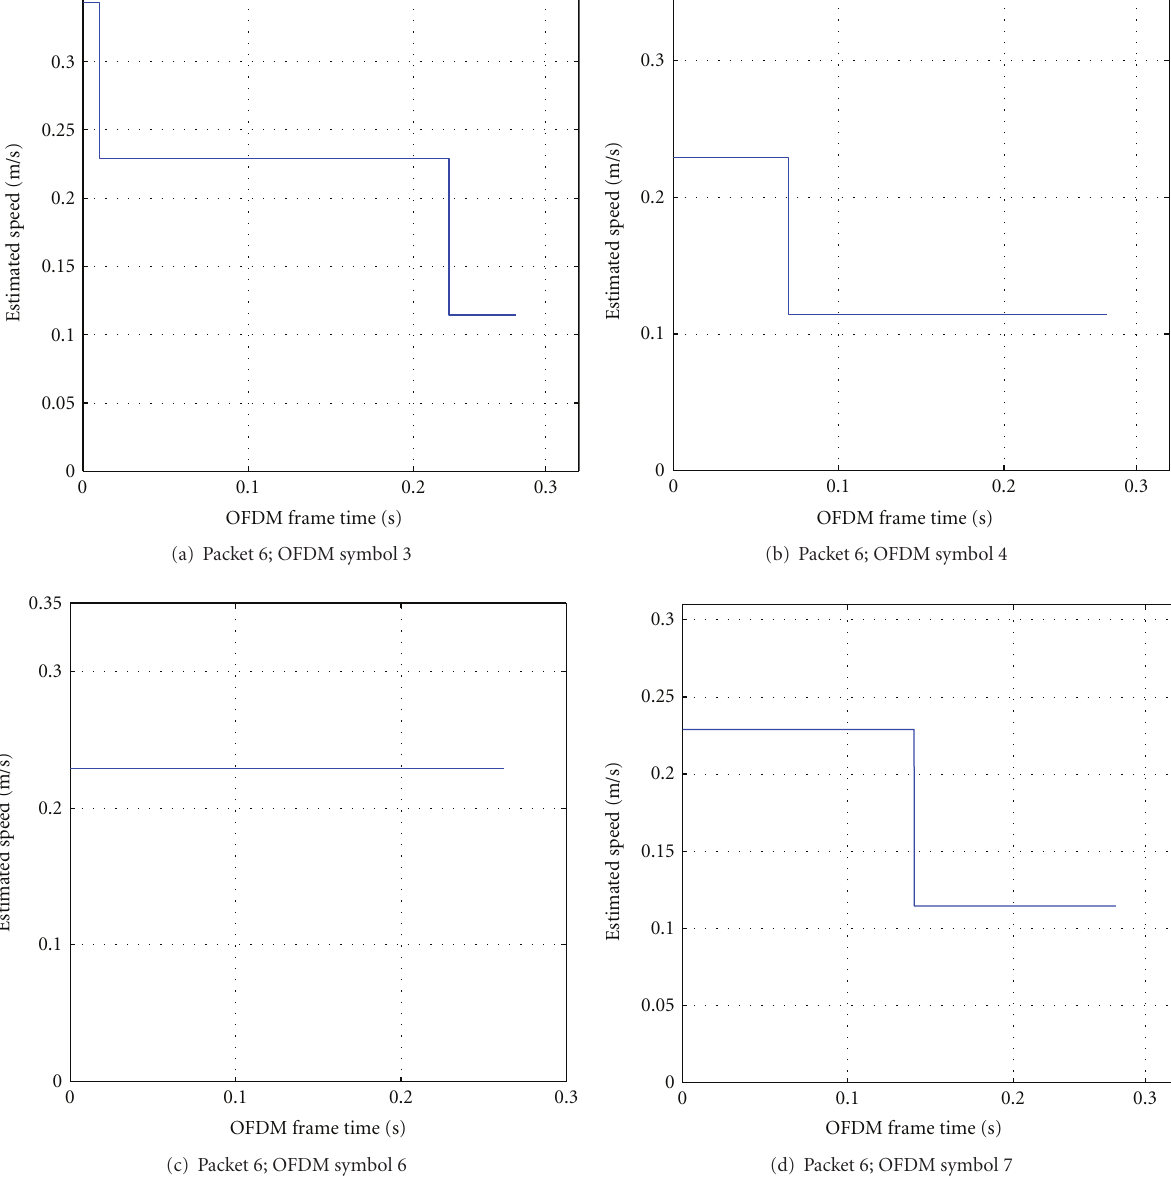
Figure 9: Estimated speed variation during OFDM